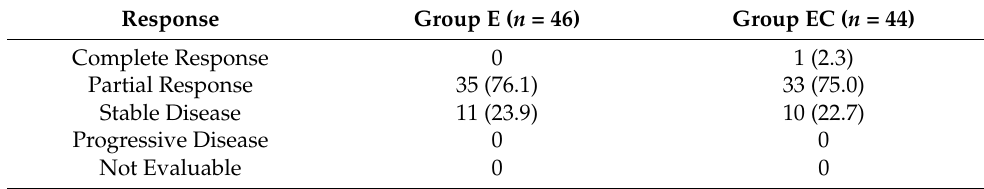
Table 3. Response to bevacizumab–paclitaxel induction